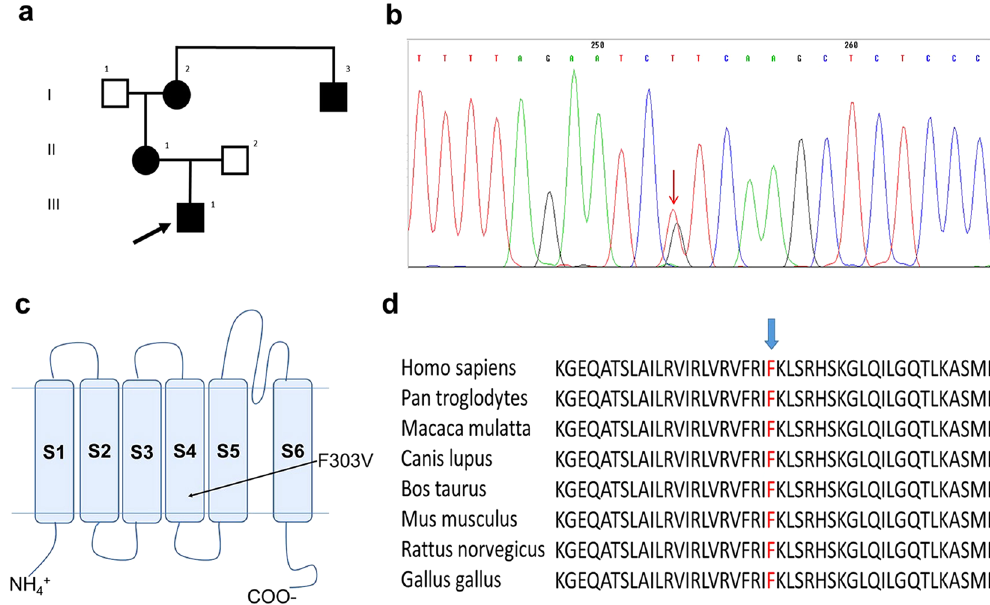
Figure 1. Detecting and analyzing the mutation. ( a ) Pedigree of patient’s family. The arrow indicates the proband, black symbols indicate affected subjects. ( b ) DNA sequencing chromatogram of a section of KCNA1 (Kv1.1) exon 2 showing the heterozygous mutation segregating in the family. The arrow indicates the c907 T > G nucleotide substitution. ( c ) Schematic topology model of the human Kv1.1 subunit showing approximate site for the F303V mutation in the S4 segment. ( d ) Alignment of the region of interest for Kv1.1 channels from various species using MUSCLE 3.6. The arrow indicates the affected